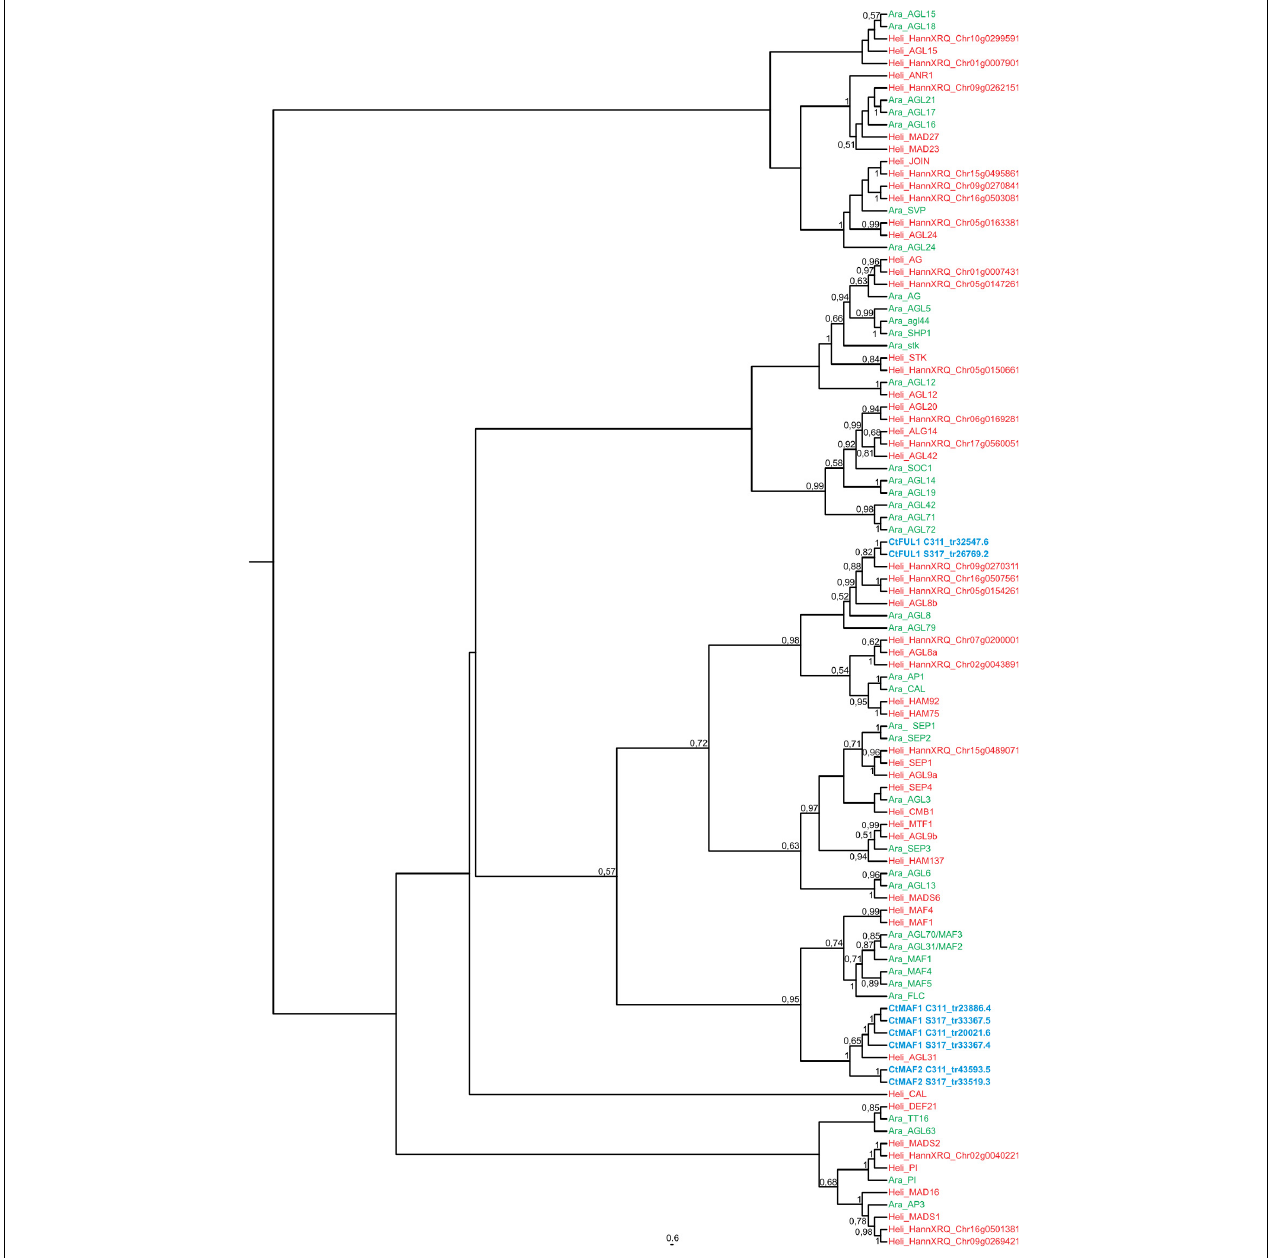
FIGURE 5 | Maximum likelihood phylogeny of the FT gene family in Arabidopsis thaliana (in green) and Helianthus annum (in red). Transcripts of Carthamus tinctorius (in green) found to be differentially expressed in response to vernalization were included. Bootstrap support values are shown for nodes with higher than 50% support. Regarding the two transcripts from the winter safflower transcriptomic assembly, namely C311_tr57705.6 and C311_tr93957.5. The former is a transcript containing a truncation at the 3 (cid:48) end that closely resembles the CtFT1 from the spring safflower transcriptome (S317_tr32761.4). The latter closely resembles C311_tr57705.6 but also contains a 5 (cid:48) truncation. Information about the genes can be found in Supplementary Table 2